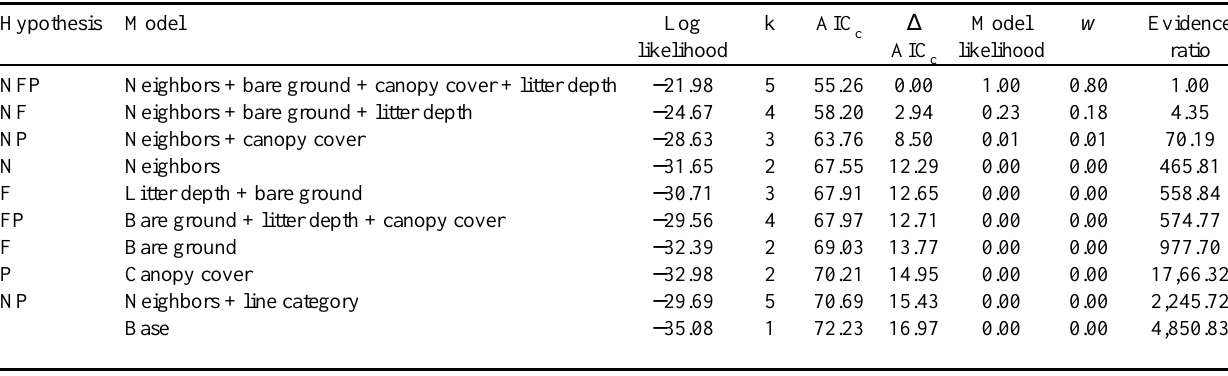
category regardless of the number of neighbors (Fig. 2). Open and medium lines were almost identical in their effect on line inclusion. Birds living next to closed lines had the highest rates of line inclusion regardless of the number of neighbors (Fig. 2). Fig. 2 . Probability that territories include lines as a function of the number of neighbors and line category. 95% confidence intervals (dotted lines) indicate whether the measured value is different from the expected value (straight line). The expected value represents the probability of inclusion if birds placed territories randomly without regard for seismic line location. Based on 100 runs, the expected rate of line inclusion simply due to chance is 65% (95% CI = +/- 1.2%; SD = +/- 6.1